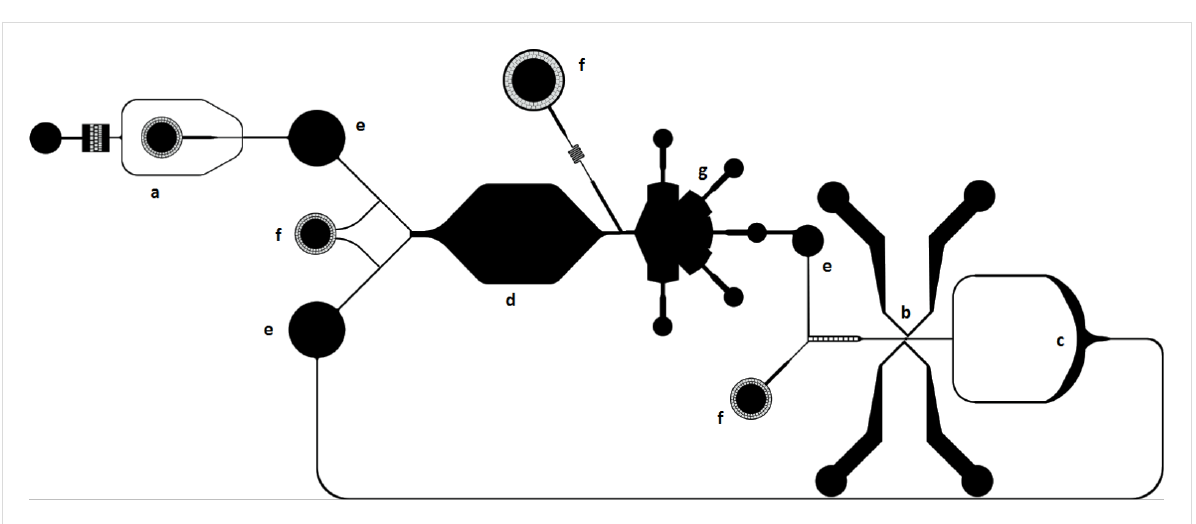
Figure 7: The proposed device for droplet selection and evolution. The device is comprised of the following modules: a) droplet generator; b) droplet fuser; c) droplet splitter; d) incubation chamber or delay line; e) droplet packing reservoirs; f) oil injectors; g) droplet size sorter.